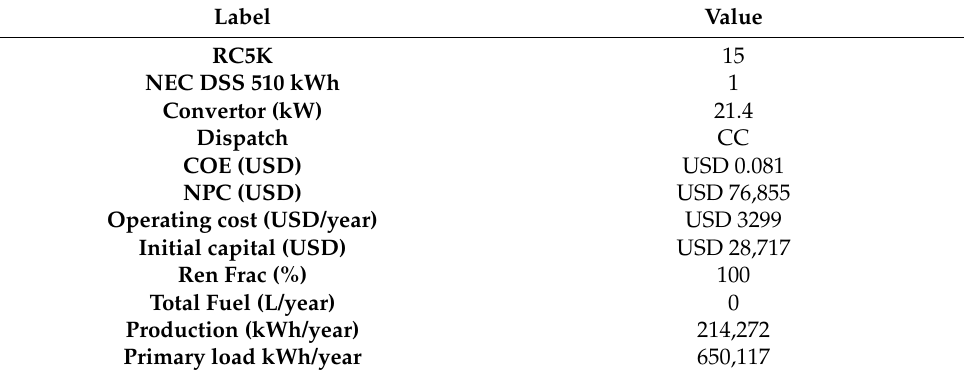
Table 6. Optimized system results based on the HOMER